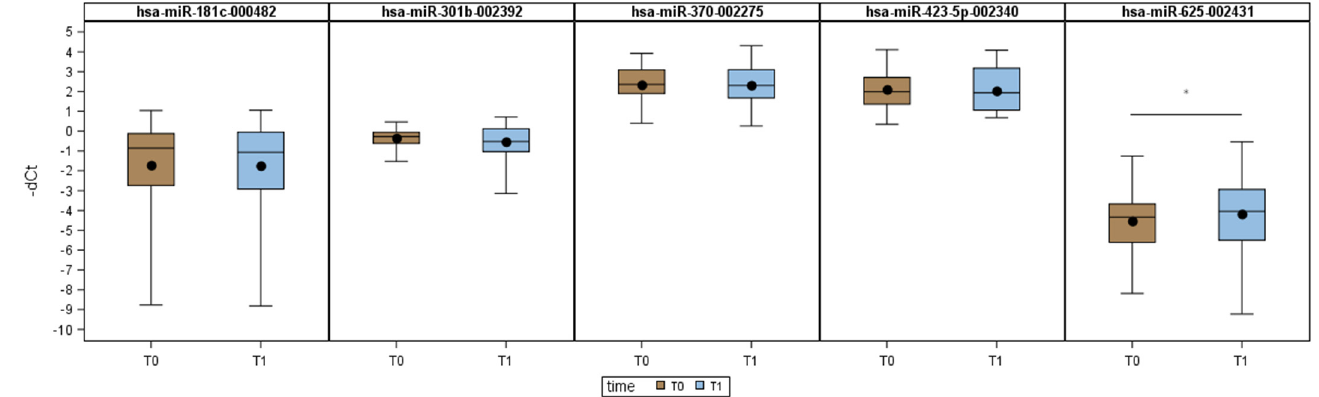
Figure 4. Evaluation of signature miRNAs at 2 time points. Distribution of each of the 5 miRNAs in signatures M1-M7 before surgery (T0) and 12 ± 3 months after surgery (T1). Each box indicates the 25th and 75th percentiles. The horizontal line in the box indicates the median, and the whiskers indicate the extremes. The black dot indicates the mean value. * if p -value < 0.05.